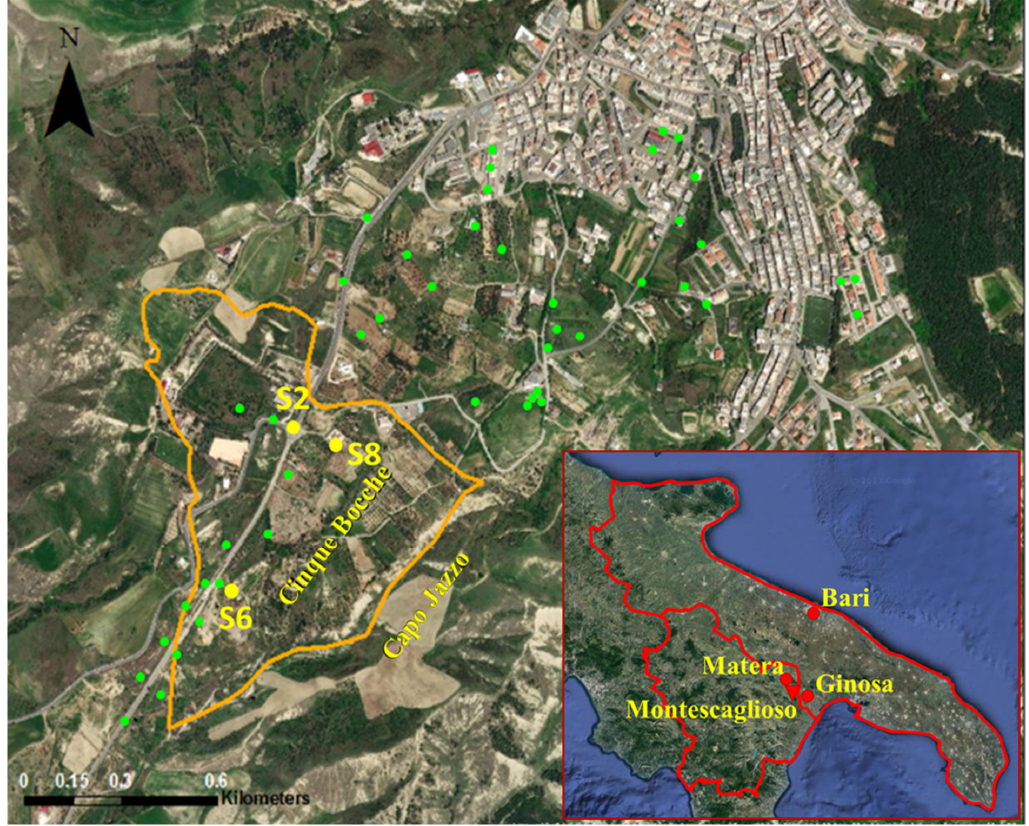
Figure 1. Aerial view of the Montescaglioso area (location in the inset) and its SW hillslope, with the landslide area in orange and locations of the Cinque Bocche and Capo Jazzo streams. In green are the locations of the boreholes performed throughout the area during several campaigns, and in yellow are the locations of the boreholes drilled after the landslide event and equipped with inclinometers (S2, S6,